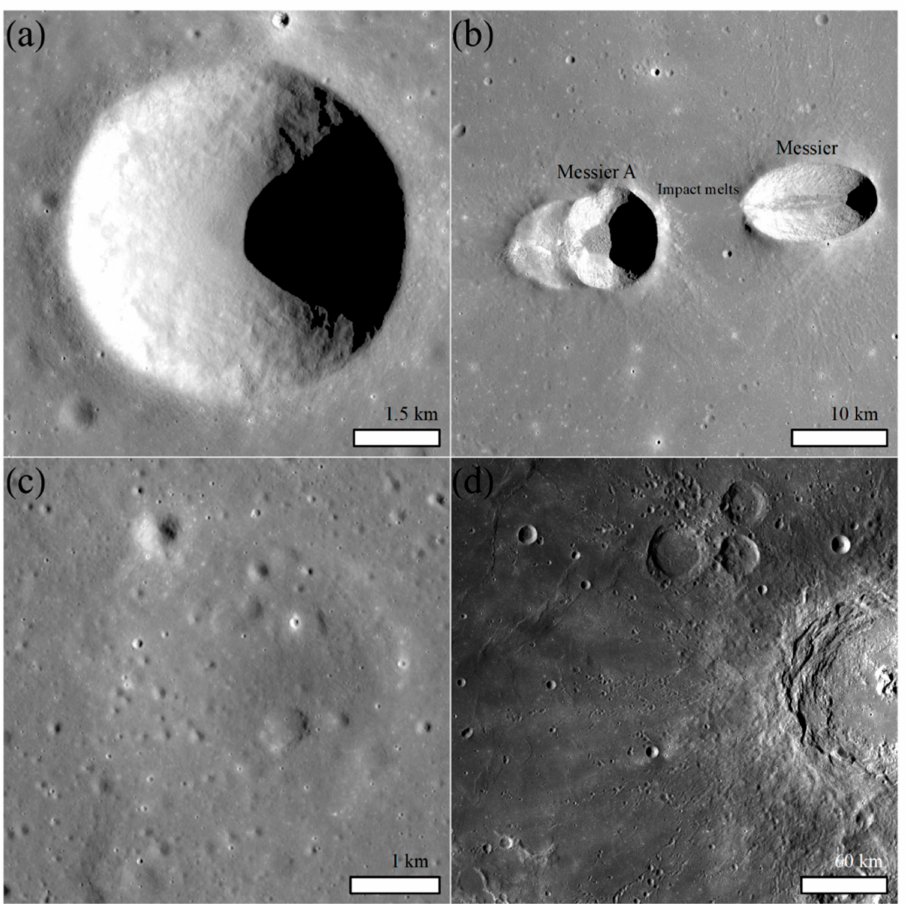
Figure 11. Different types of craters in Mare Fecunditatis. ( a ) A simple crater (0.2 ◦ S, 45.5 ◦ E), shown with a TC image; ( b ) Messier (1.9 ◦ S, 47.7 ◦ E), Messier A (1.97 ◦ S, 46.95 ◦ E), and smooth impact melts, shown with a TC image; ( c ) a buried crater (3.10 ◦ N, 53.78 ◦ E), shown with a TC image; ( d ) crater chains on the south of Langrenus (8.8 ◦ S, 61.2 ◦ E), shown with a WAC